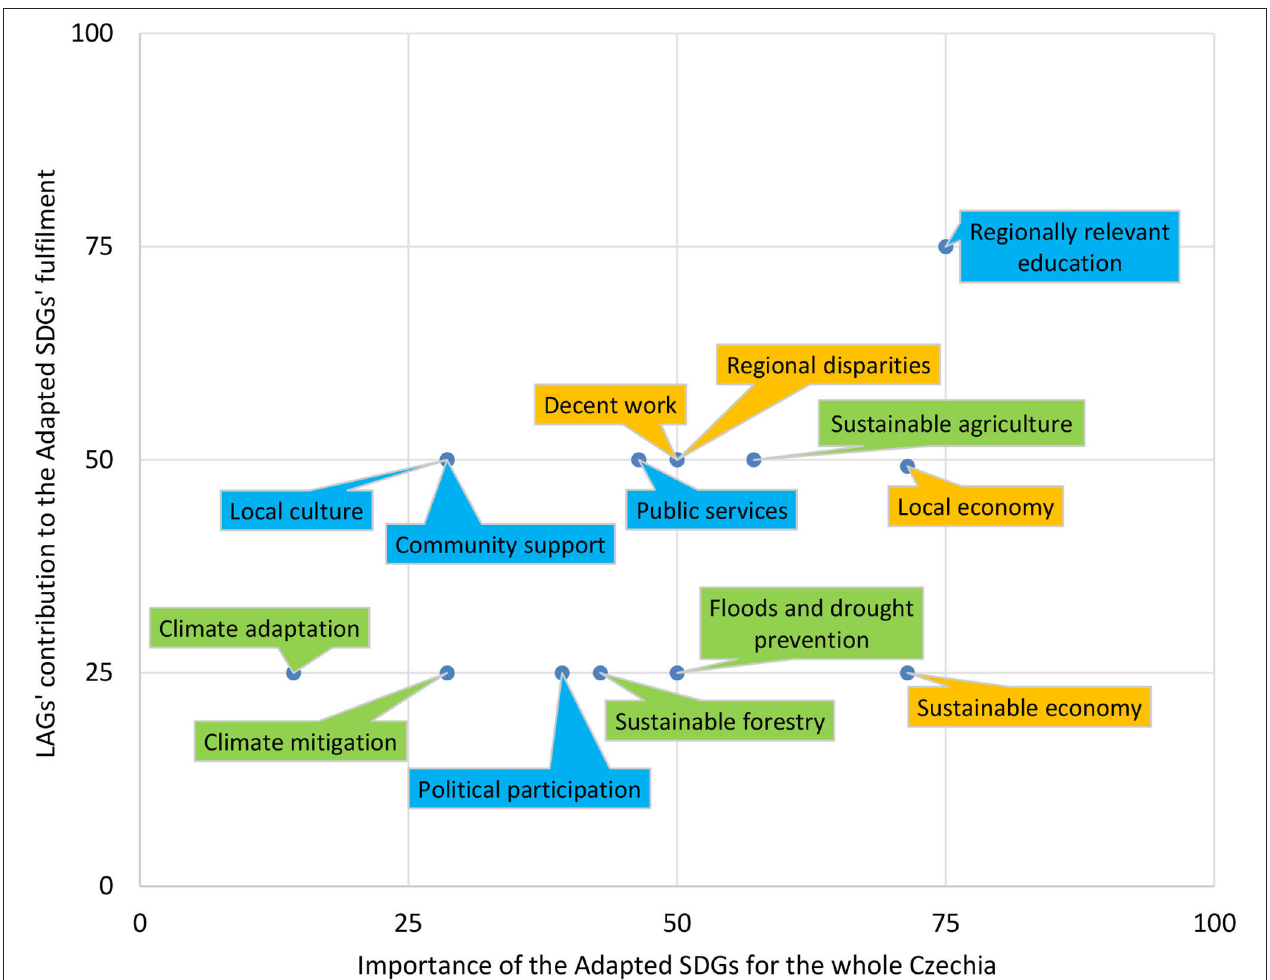
FIGURE 3 | Adapted SDGs’ importance and LAGs’ contribution to their fulfillment. The figure shows relation of the perceived importance of the Adapted SDG for whole Czechia (Y axis) and contribution to its fulfillment assessed by the respondent’s LAG (X axis). Overall importance is calculated as normalized median of the Adapted SDGs’ ranking (see Figure 2 ). LAG’s contribution is calculated as median of answers: 1 = “Yes, the LAG contributes significantly”; 2 = “The LAG contributes and could do more…”; 3 = “The LAG does not contribute but could…”; 4 = “The LAG cannot contribute” (see Table 1 ). Answer “Do not know” was omitted; therefore, the number of respondents varies ( N ranges from 35 to 42). The numbers were transformed and normalized on the 0–100 scale (100 being most important for both axes). The colors show the main dimension of the Adapted SDG: environmental is green, economic is yellow, and social is